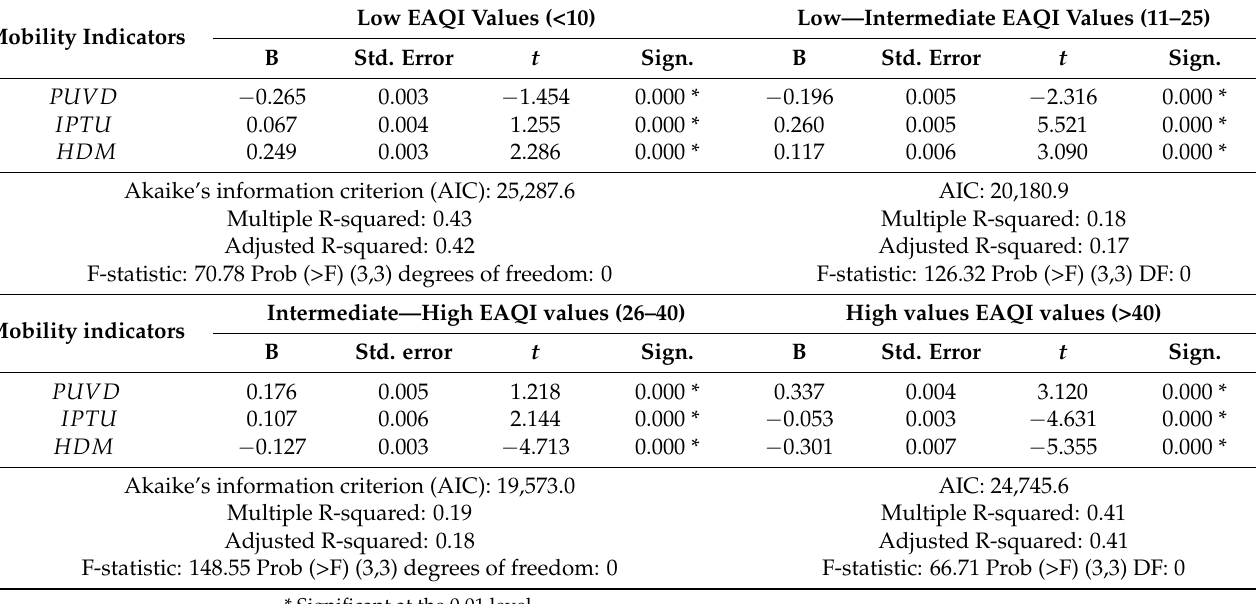
Table 2. Detailed multiple regression models (OLS) for LISA bidimensional analysis of the different levels of air quality index.